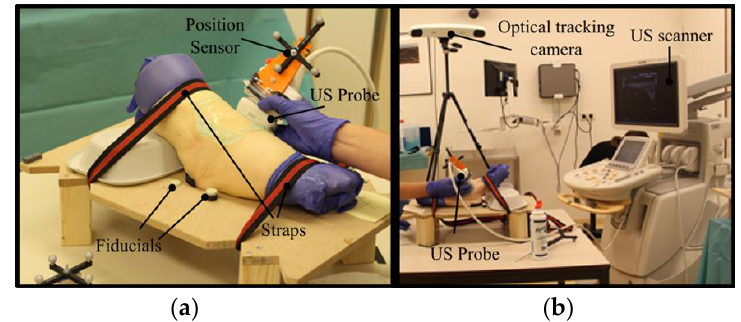
Figure 2. Experimental settings in the ultrasound room. ( a ) Prior to CT imaging and US sweeping, each cadaveric ankle was placed on a foot plate in maximal plantar flexion and was tightened using